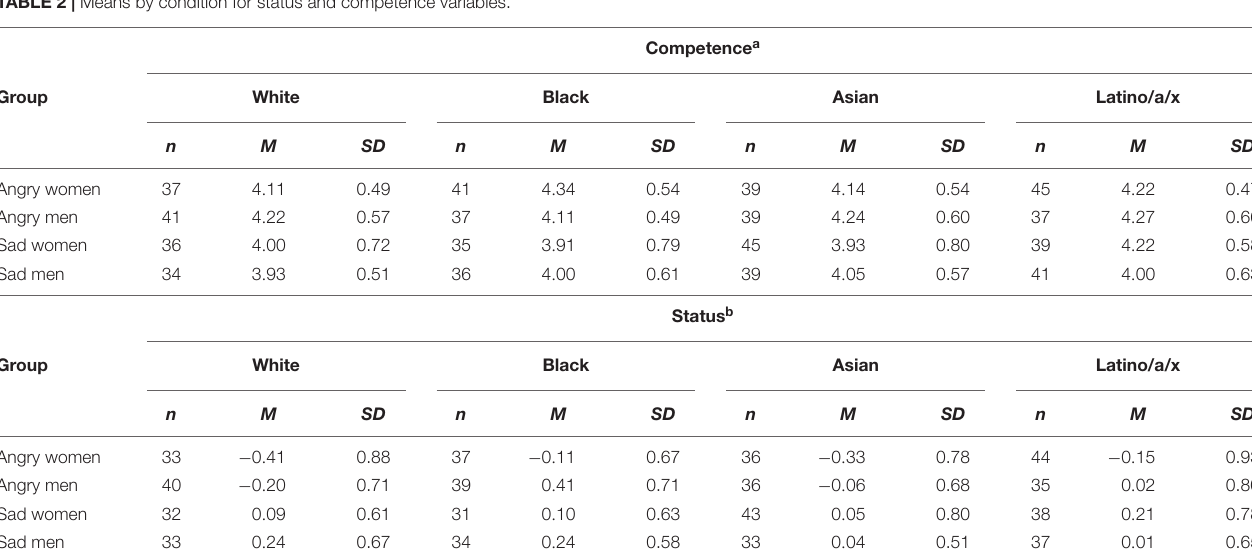
TABLE 2 | Means by condition for status and competence